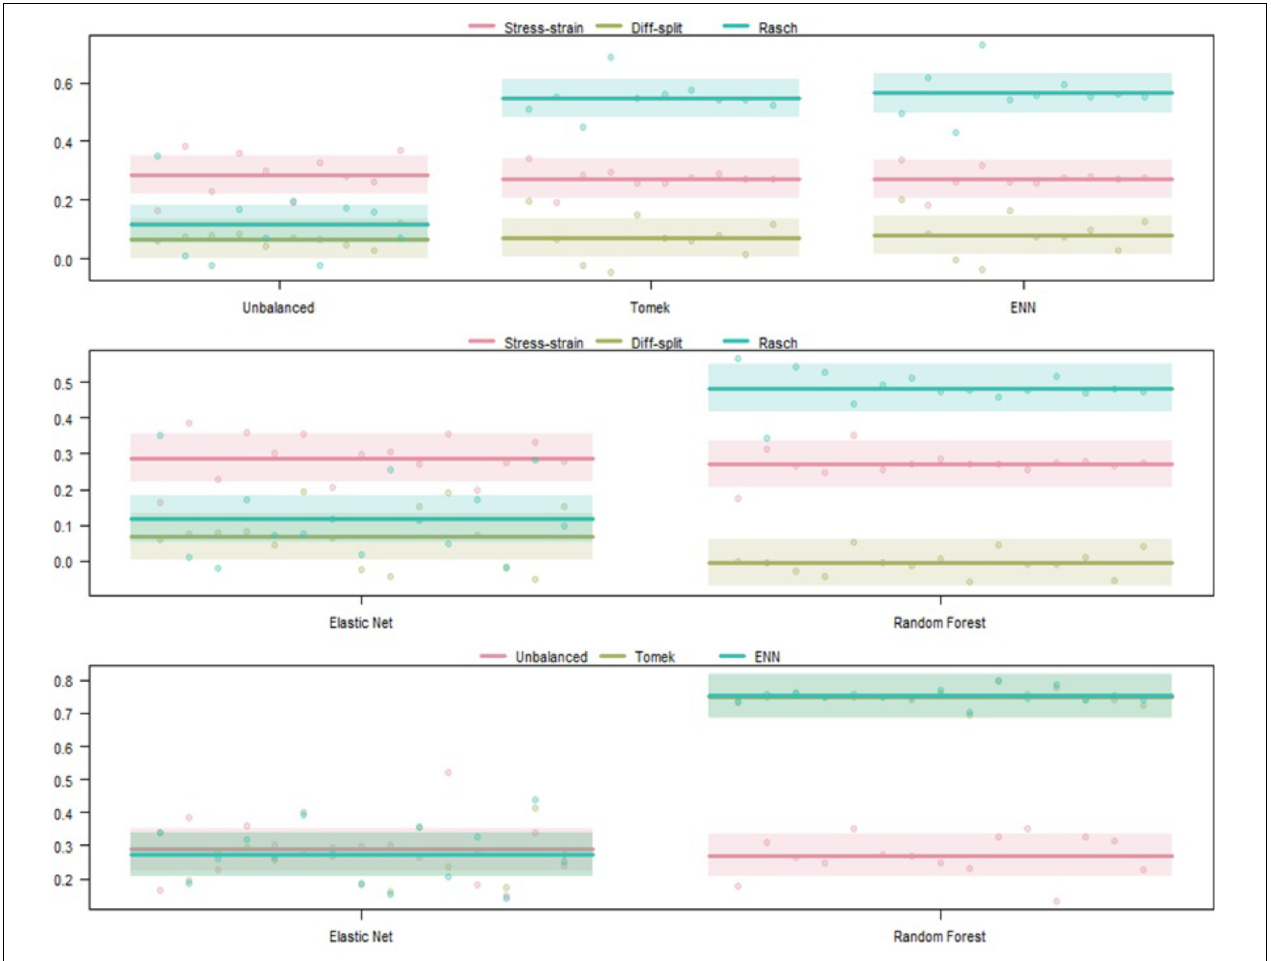
FIGURE 4 | Regression estimates for fivefold cross-validation on the ISR task across various combinations of techniques. Points along the y -axis are GINI Index values for individual folds, lines are the regression estimate, and bars are the error of the estimate. (Top) Balancing techniques and labeling methods, (Middle) machine learning algorithms and labeling methods, and (Bottom) machine learning algorithms and balancing techniques.